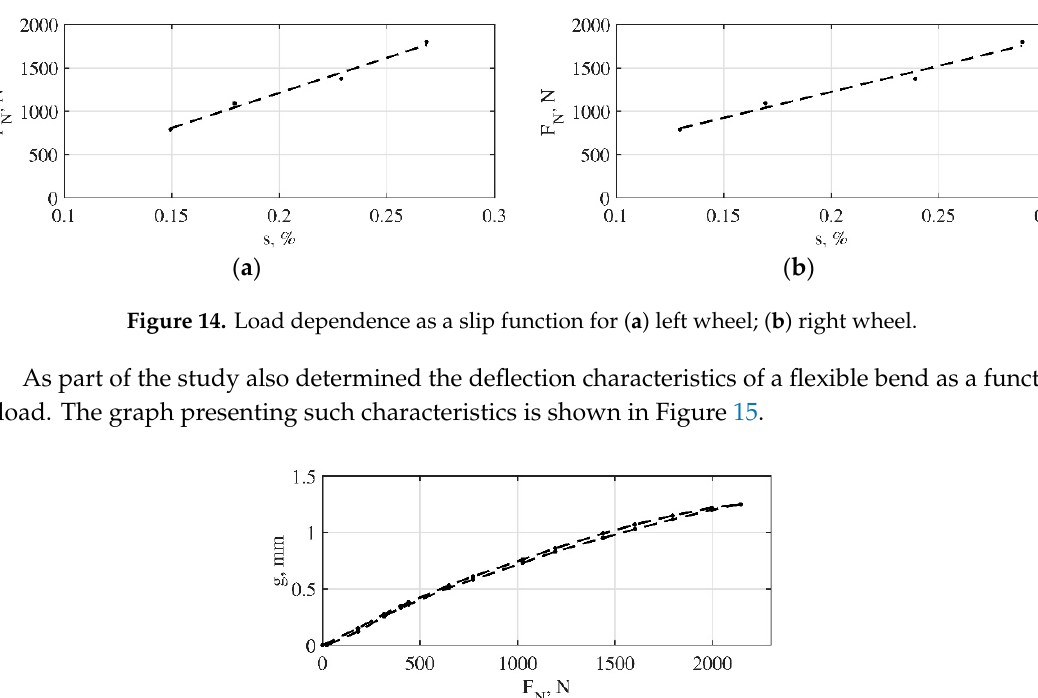
Figure 13. Comparison of the obtained rolling radius courses.